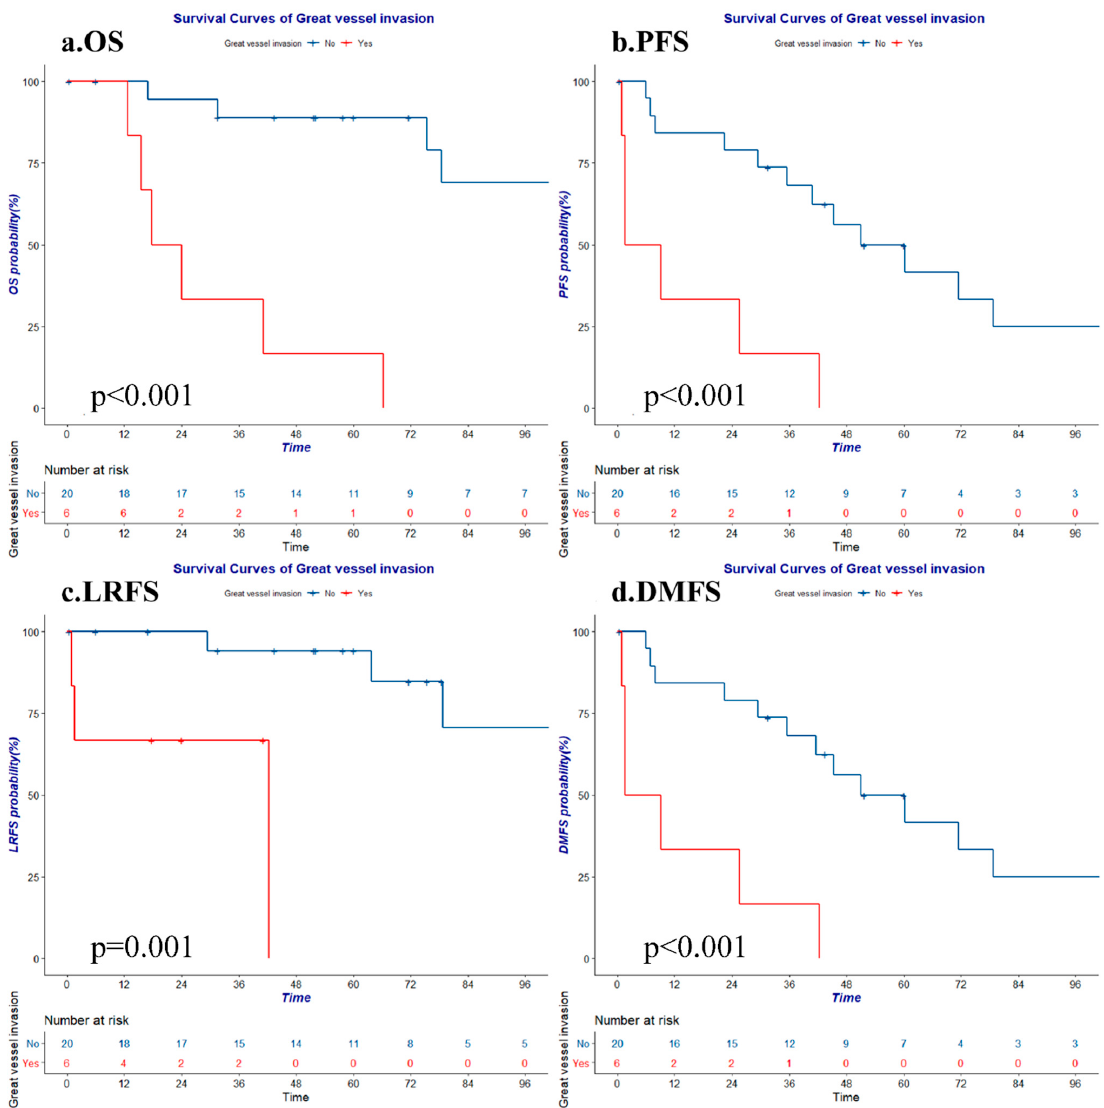
Figure 2. The OS, PFS, LRFS, and DMFS of lesions with or without great vessel invasion. ( a ) OS: overall survival; ( b ) PFS: progression-free survival; ( c ) LRFS: local-regional relapse free survival; ( d ) DMFS: distant metastasis-free survival.